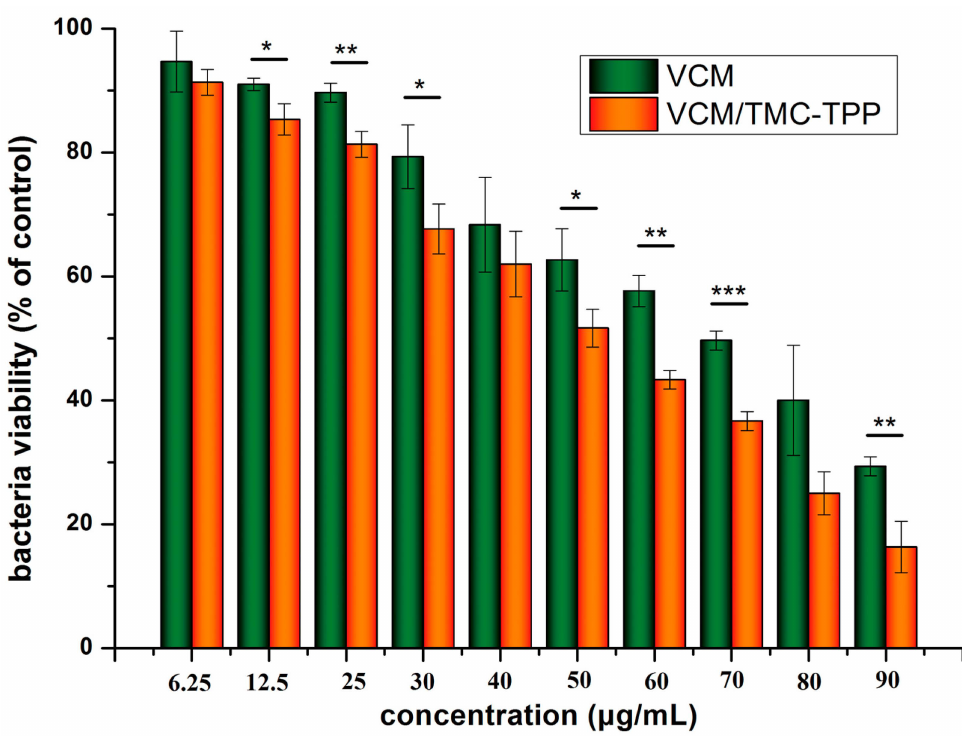
Figure 14. TB assay of VCM/TMC nanoparticles and VCM solution against S. aureus . *** , p < 0.001; ** , p < 0.01; and * , p <